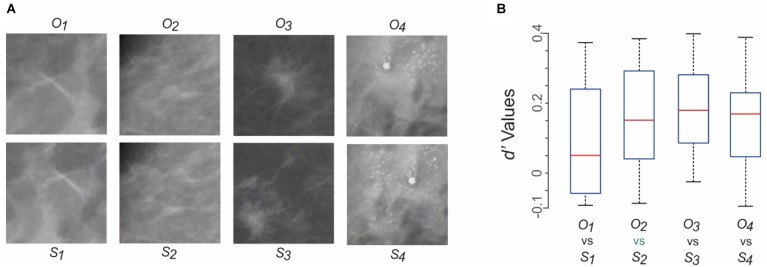
Can practicing radiologists tell the synthesized mammograms from their original counterparts? Results of Experiment 1. (A) Mammograms tested in Experiment 1. Four different original mammograms (O1 through O4) and their synthesized counterparts (S1 through S4) were chosen as test stimuli. Fourteen radiologists, each a practicing mammography specialist, viewed each image ad libitum, and reported whether it was a synthesized image or an original one. See text for details. The first two columns from left represent healthy breasts, and the last two columns represent cancerous ones. (B) The subjects’ responses were analyzed using d’ analysis. The resulting d’ values are shown as four box plots corresponding to the four pairs of stimuli in panel A. For each box plot, the top and bottom “whiskers” represent the maximum and minimum observed d’ values, respectively. The rectangle denotes the interquartile range between the first and third quartile of observed values. The red horizontal line denotes the median value. None of the d’ values were statistically significant (p > 0.05 for all values).